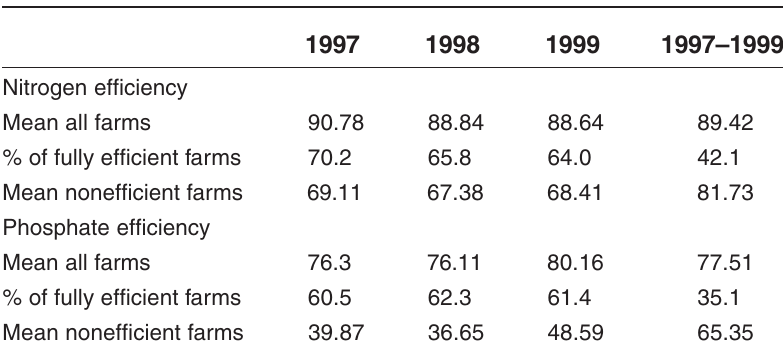
OLS Regression Results of Nutrient Efficiency and Farm Intensity on Surpluses *